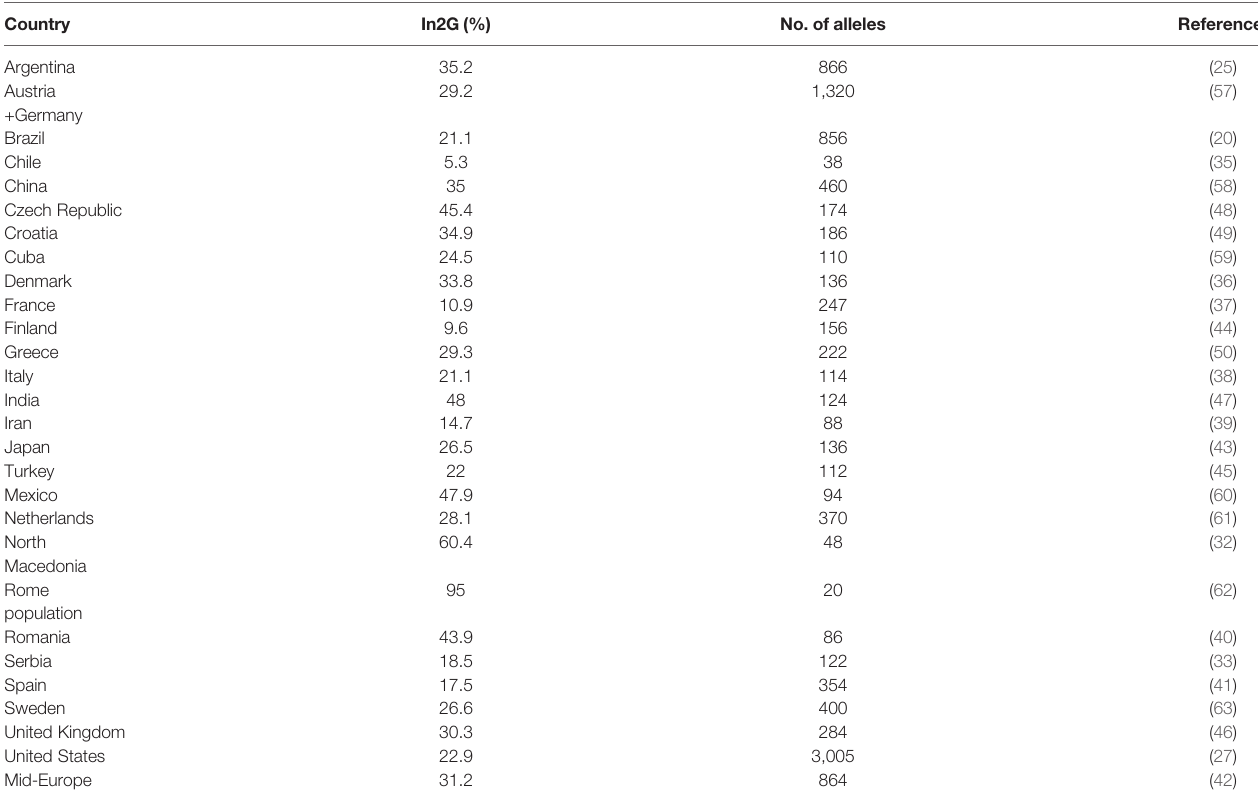
TABLE 1 | Prevalence of In2G variant in different countries. Country In2G (%) No. of alleles Reference